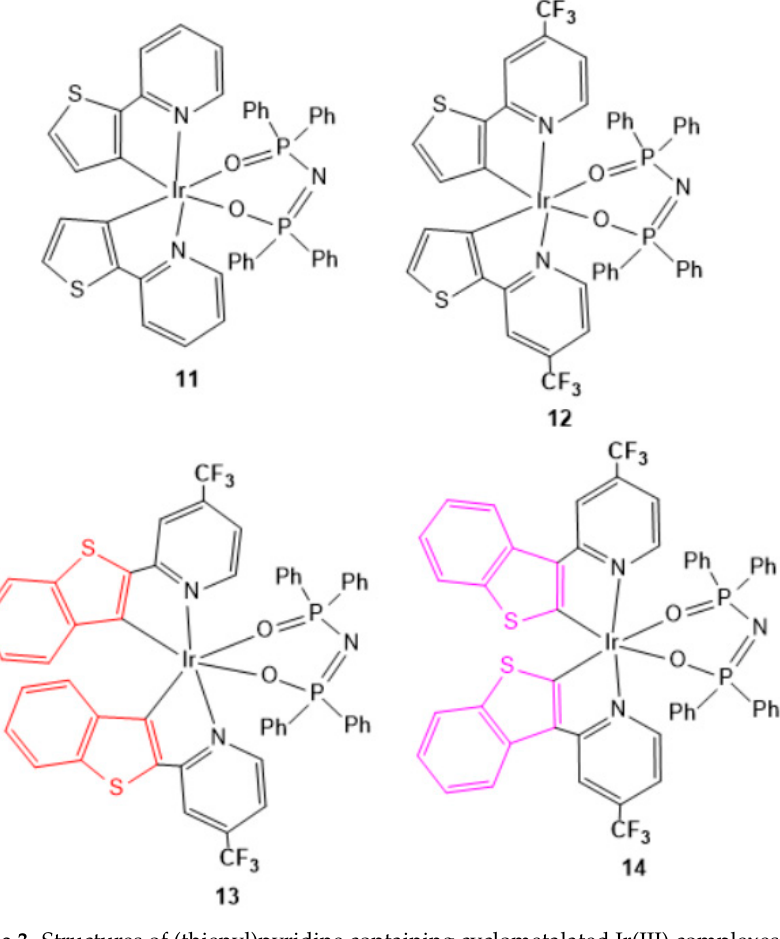
Scheme 3. Structures of (thienyl)pyridine containing cyclometalated Ir(III) complexes [56].